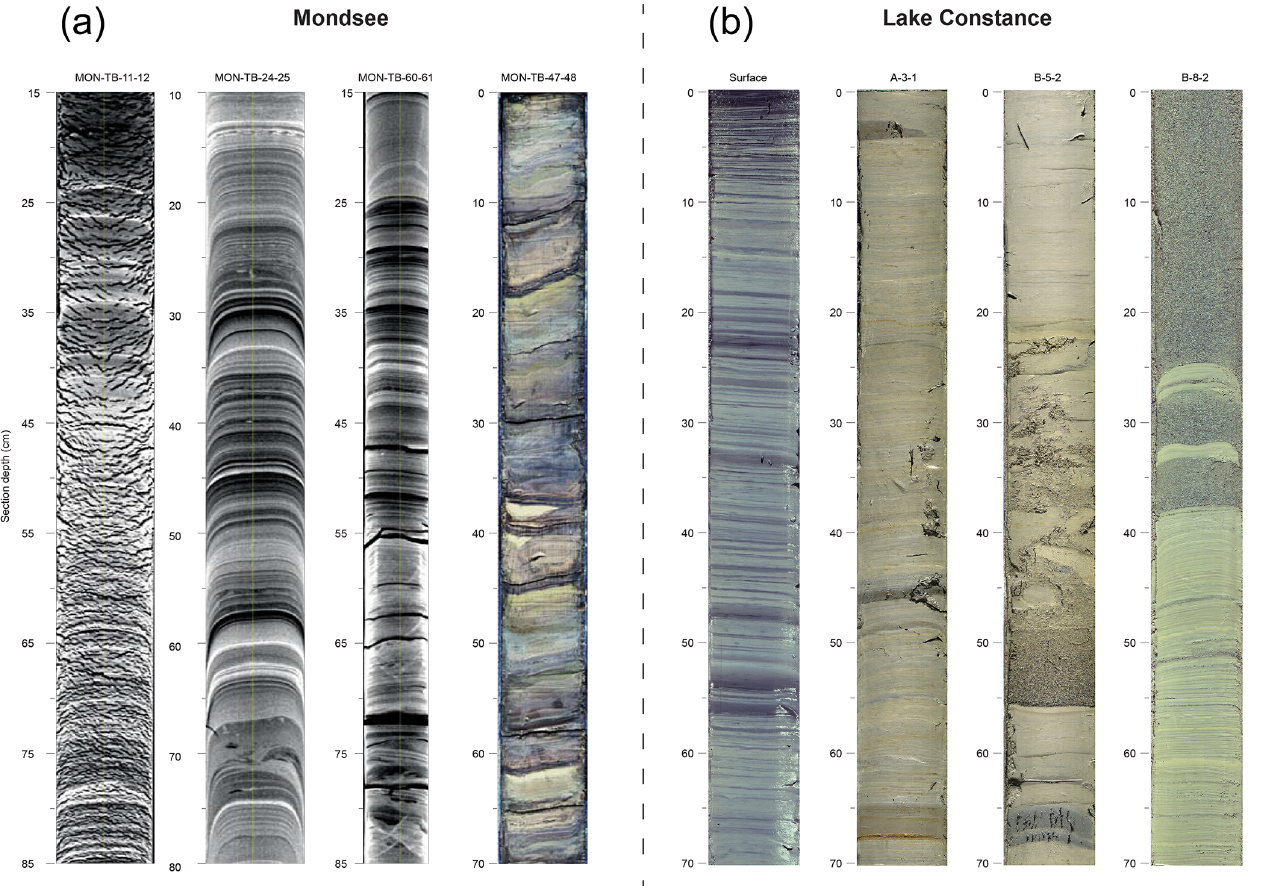
Figure 8. (a) Examples from the X-ray computed tomography (XCT) scan (the first three sections from the left; labeled numbers on top of sections indicate subsurface depth range of 1m core segments) and core photos from Mondsee (histogram-equilibrated images at depth intervals of 47.0–47.7mb.l.f.) and Lake Constance (four segments to the right). Note the frequent gas expansion cracks in the XCT segment of Mondsee (11.15–11.85mb.l.f.) and dense (high XCT value in white) conjugated faults at Mondsee (60.80–60.85mb.l.f), which are further discussed in the text. (b) Four examples of line-scan images from core sections of Lake Constance’s composite sections. Depth in centimeters indicates section depths. From left to right: surface core (0–70cm in meters composite depth – mcd); finely layered brown-gray laminated muds with upcore increasingly darker colors (eutrophication signal); core A-3-1 (5.75–6.45mcd) – carbonate-rich tan and laminated